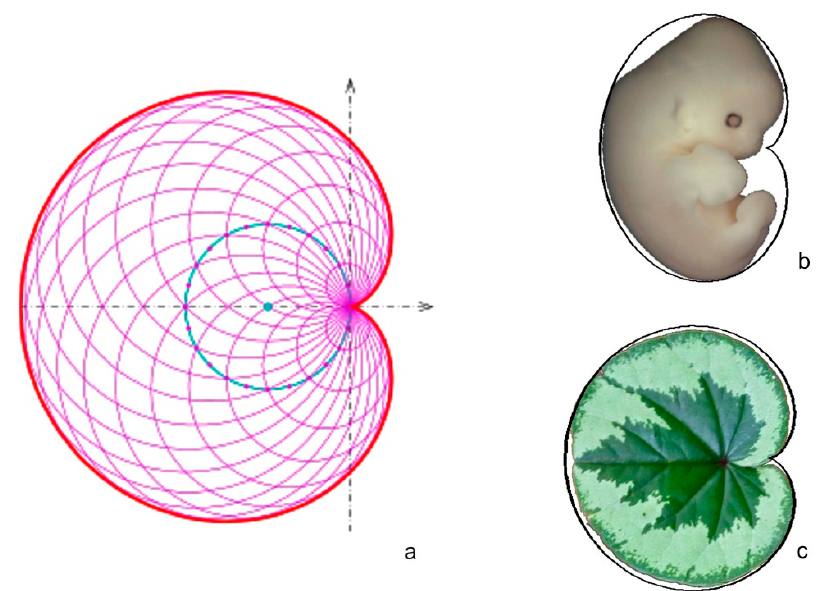
Figure 2. ( a ) The cardioid visualized as the envelope of a pencil of circles formed in a way that their midpoints lie on the perimeter of the fixed generator circle. The cardioid shape is common in embryos ( b ) and leaves ( c ).